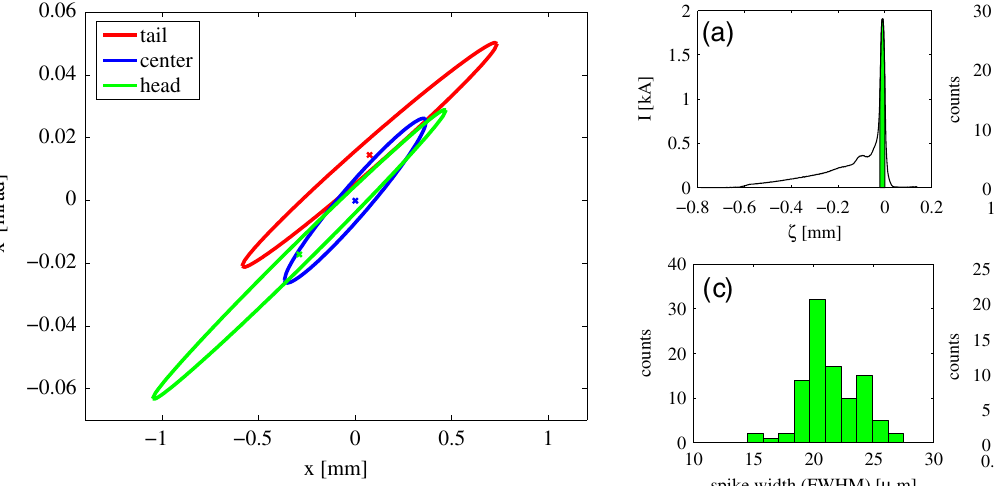
TIME-RESOLVED ELECTRON BEAM PHASE SPACE . .